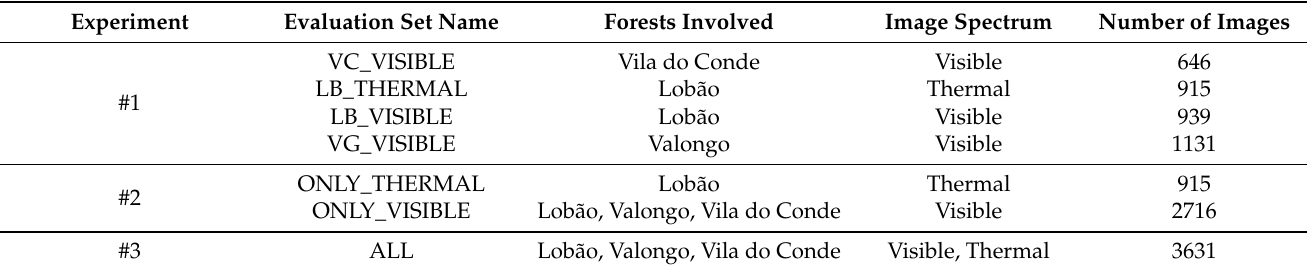
Table 4. Evaluation image sub-subsets for DL inference for each evaluation experiment.